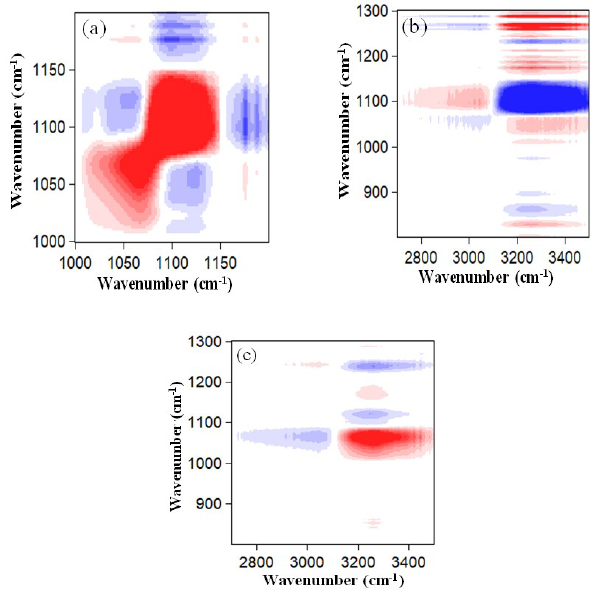
Figure 9. The same as Fig. 7 but for AS /